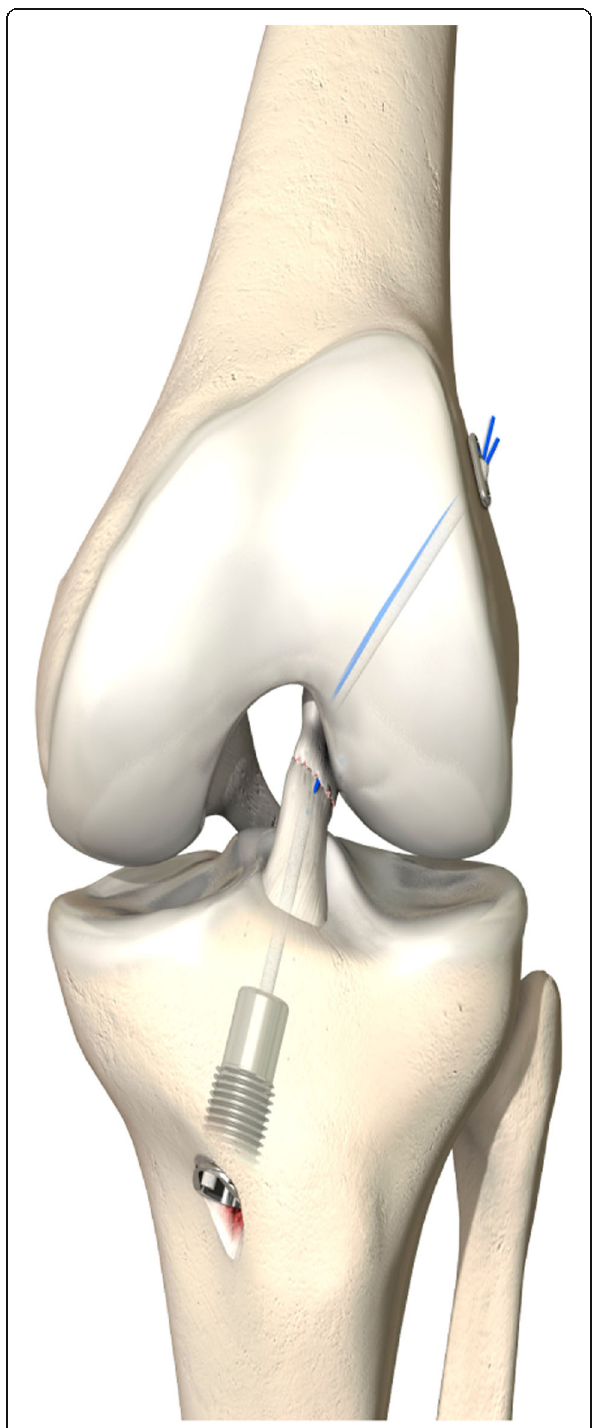
Fig. 3 Dynamic intraligamentary stabilization (DIS) with Ligamys ™ device (figure supplied by and reproduced with permission from MATHYS European